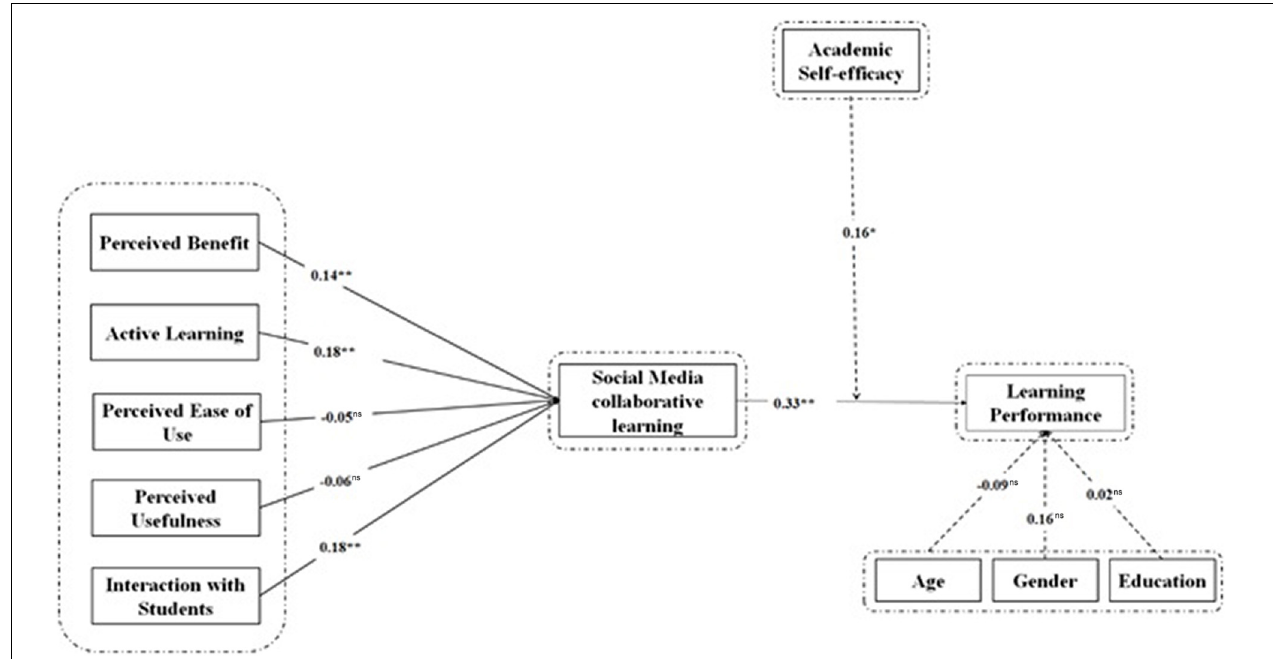
FIGURE 1 | Structural model. * p < 0.05, ** p < 0.001. ns, non-significant.